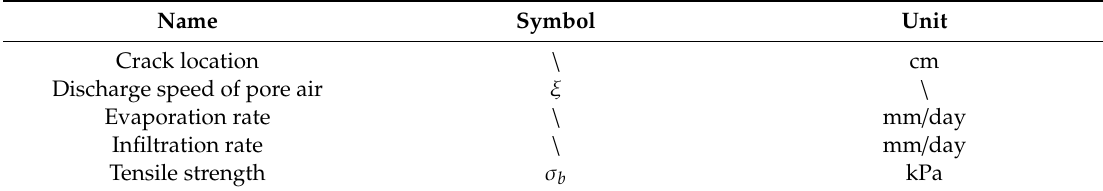
Table 1. Parameters changed in subsequent